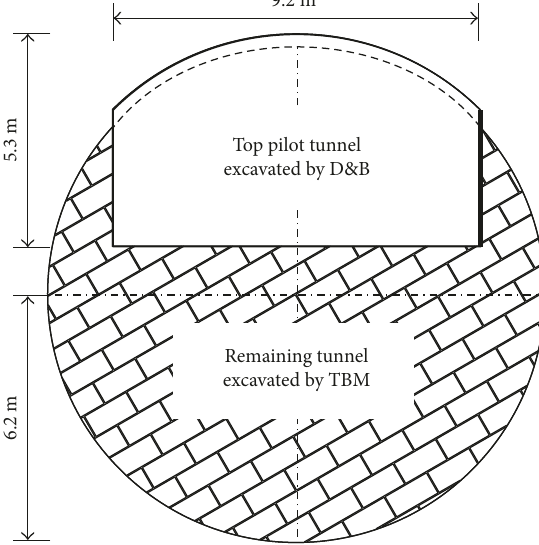
Figure 7: The cross section of the top pilot tunnel.